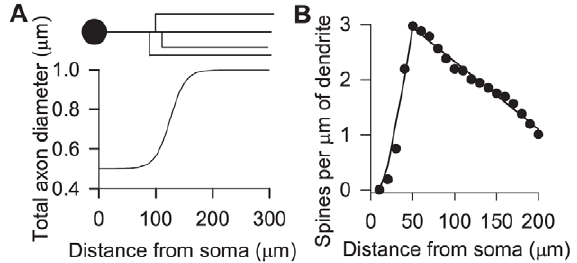
Figure 4. Elements of neurite modelling. A The axon diameter model. The schematic MSN axon (top) shows the assumption that all branches occur over a short interval of * 50 { 200 m m . This is modeled as a continuous increase in axon diameter for convenience. B Spine density data ( . ) from [59] and our piece-wise linear fit (see equation 6).